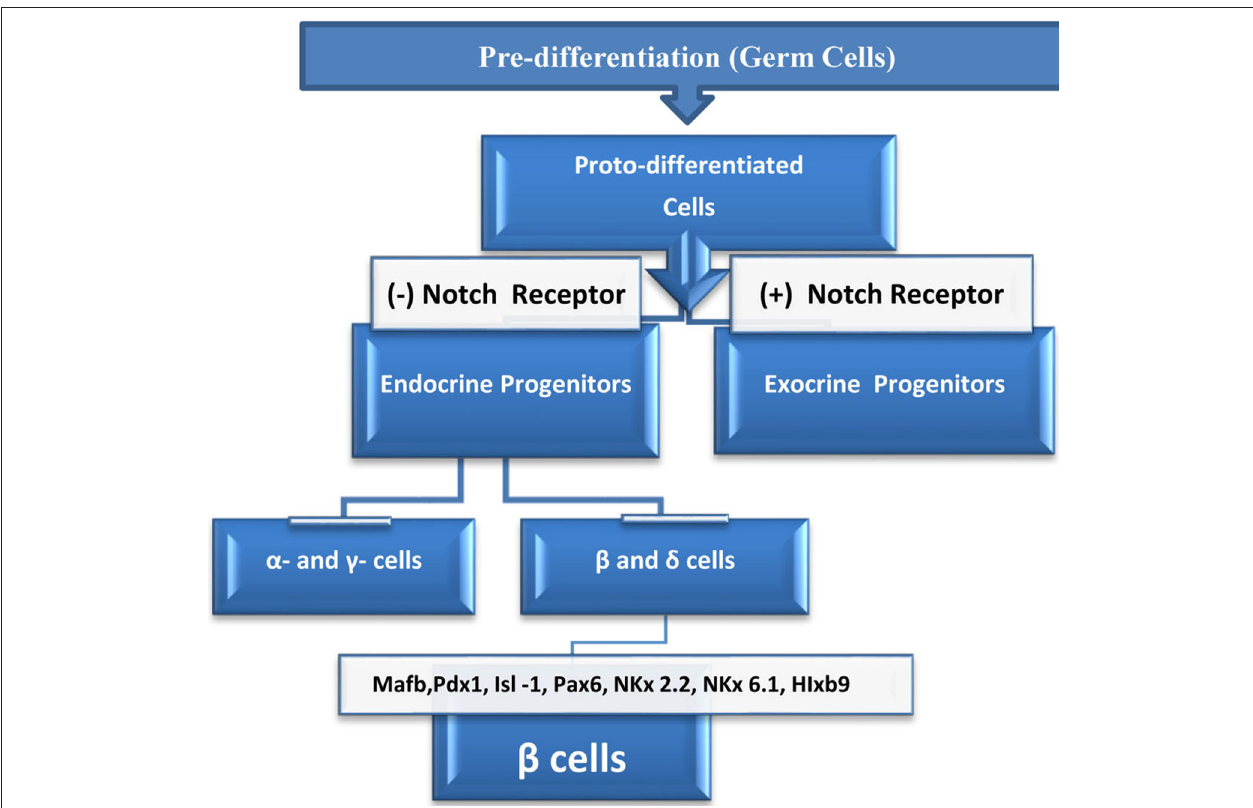
FIGURE 1 | Life cycle of β cells starts at the embryonic germinal stage where pre-differentiated cells changed into proto-differentiated stage under a specific signal. Thereafter, cells express Notch protein which bind to Notch receptor and activate downstream genes, and cells become exocrine progenitors. Cells which lack Notch protein expression, proceeds to form subset of endocrine progenitor cells which continue to differentiate into alpha ( α ), epsilon ( ε ) or to beta ( β ), and delta ( δ ) cells. In the presence of the transcriptional signals above, beta ( β ), and delta ( δ ) cells continue differentiation to become β cells which eventually mature to insulin producing